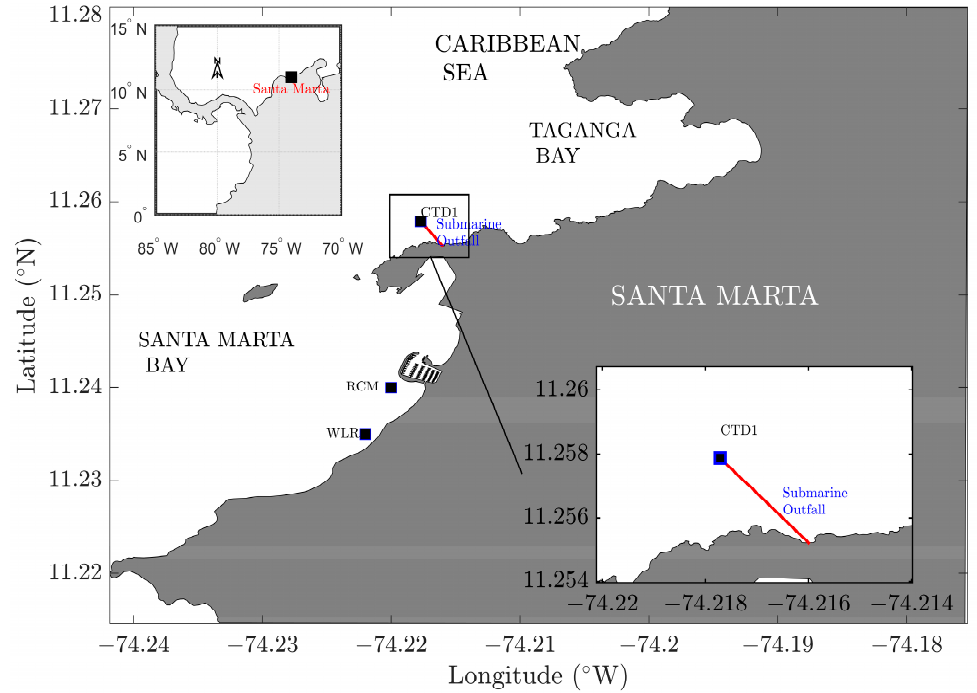
Figure 1. Location of the submarine outfall at Santa Marta Bay, CTD1 = temperature and salinity measurement station, RCM = current measurement station, WLR = Water level measurement station.